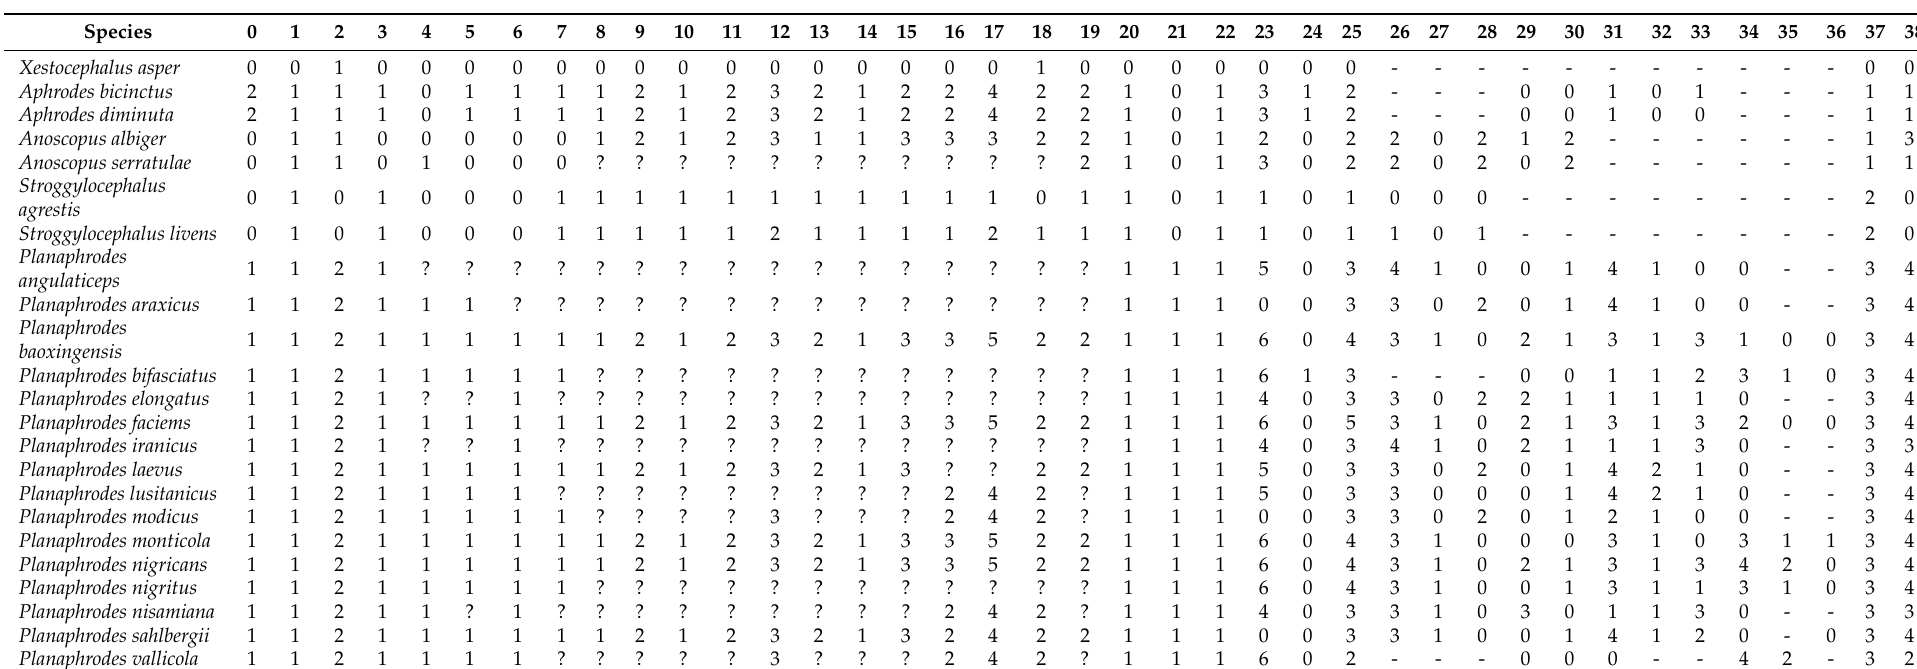
Table 1. Character state distribution used in cladistic